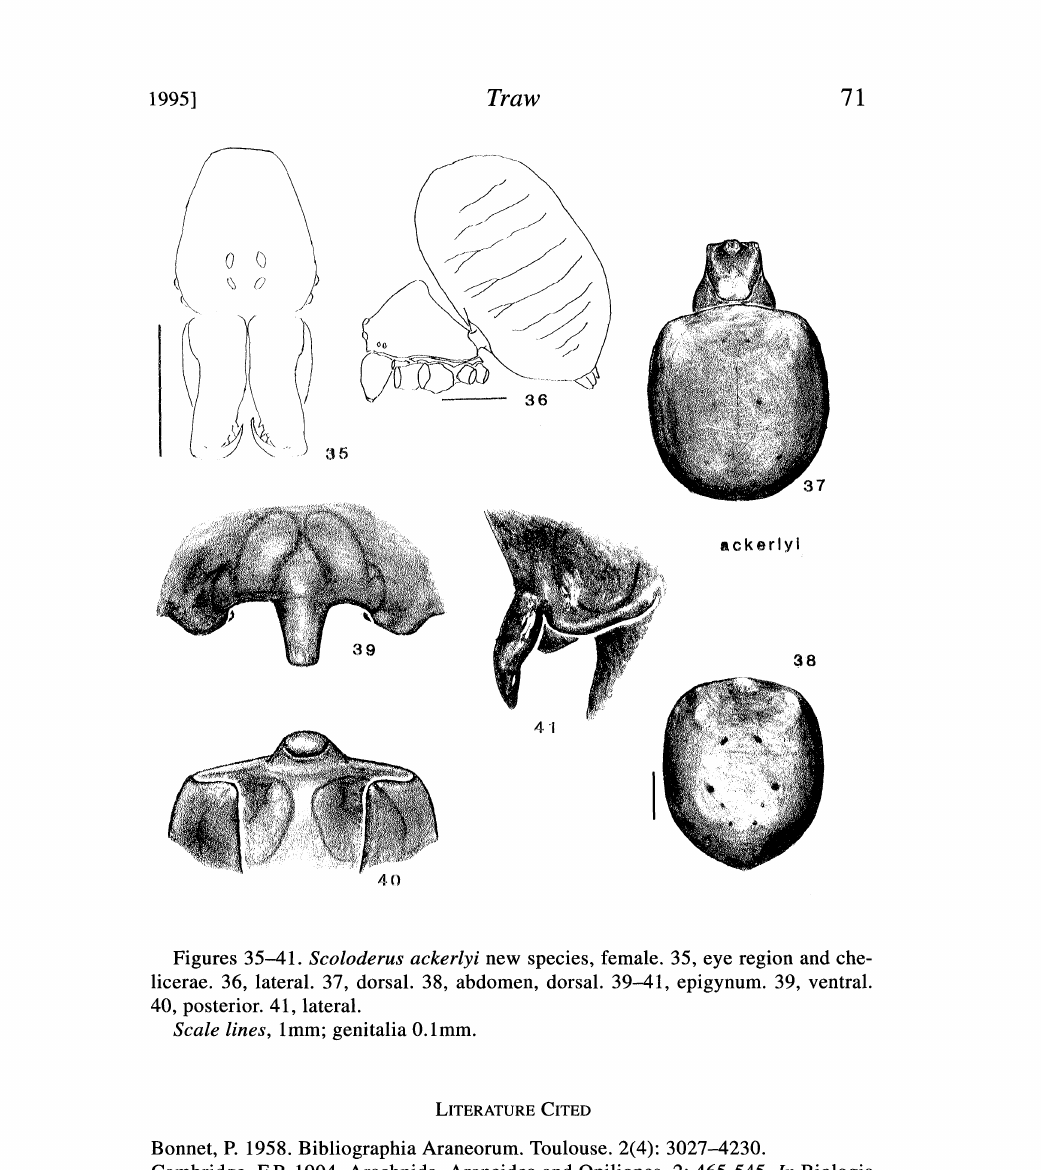
Figures 35-41. Scoloderus ackerlyi new species, female. 35, eye region and che- licerae. 36, lateral. 37, dorsal. 38, abdomen, dorsal. 39-41, epigynum. 39, ventral. 40, posterior. 41, lateral. Scale lines, lmm; genitalia 0.